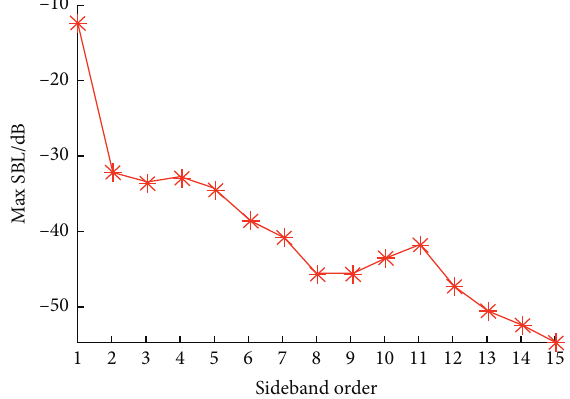
Figure 6: The SBL from the first sideband to the 15 th sideband.